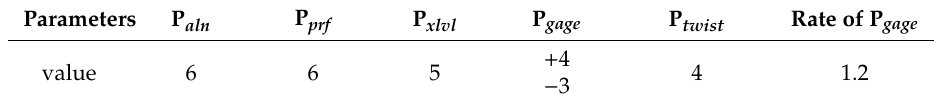
Table 14. Peak management standard-I levels for the geometric parameter for the speed of 200~250 km / h. Parameters P aln P prf P xlvl P gage P twist Rate of P gage